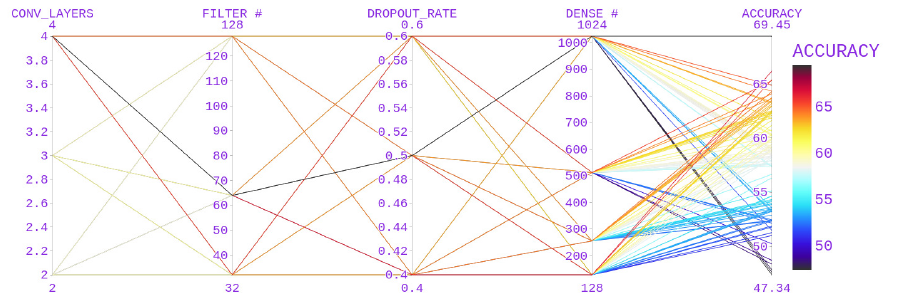
Figure 7. Parameter Selection for the 3D